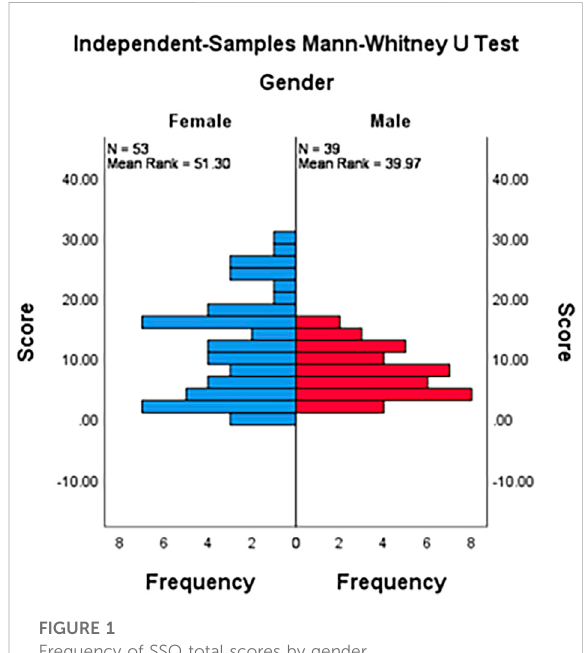
FIGURE 1 Frequency of SSQ total scores by gender.